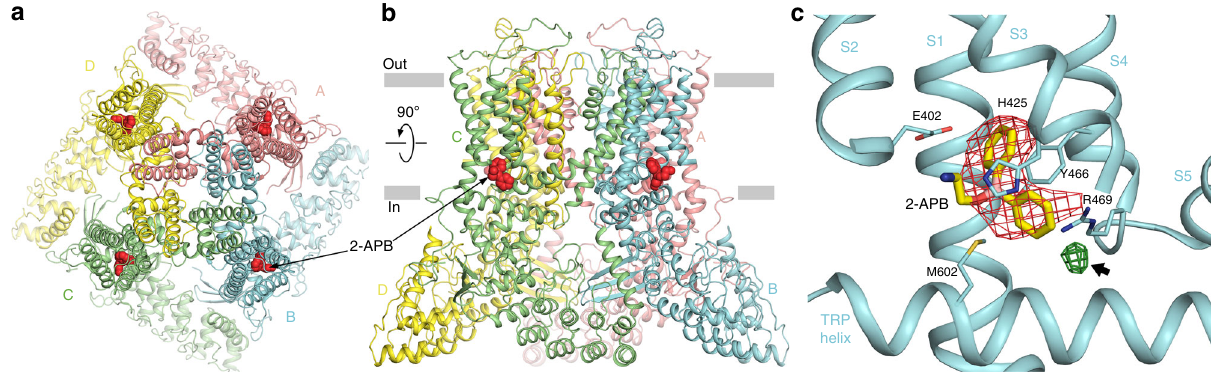
Fig. 2 Crystal structure of rat TRPV6 in complex with 2-APB. a , b Top ( a ) and side ( b ) views of TRPV6* in complex with 2-APB. The molecules of 2-APB are shown as red space- fi lling models. Four TRPV6* subunits are colored pink, cyan, green, and yellow. c Close-up view of the 2-APB binding site with 2-APB (yellow) and surrounding residues shown as sticks. Red mesh shows positive electron density for 2-APB in the Fo – Fc omit map contoured at 3 σ . Green mesh indicated by the arrow shows electron density for the brominated derivative of 2-APB (2-APB-Br) in the anomalous difference Fourier map contoured at 3